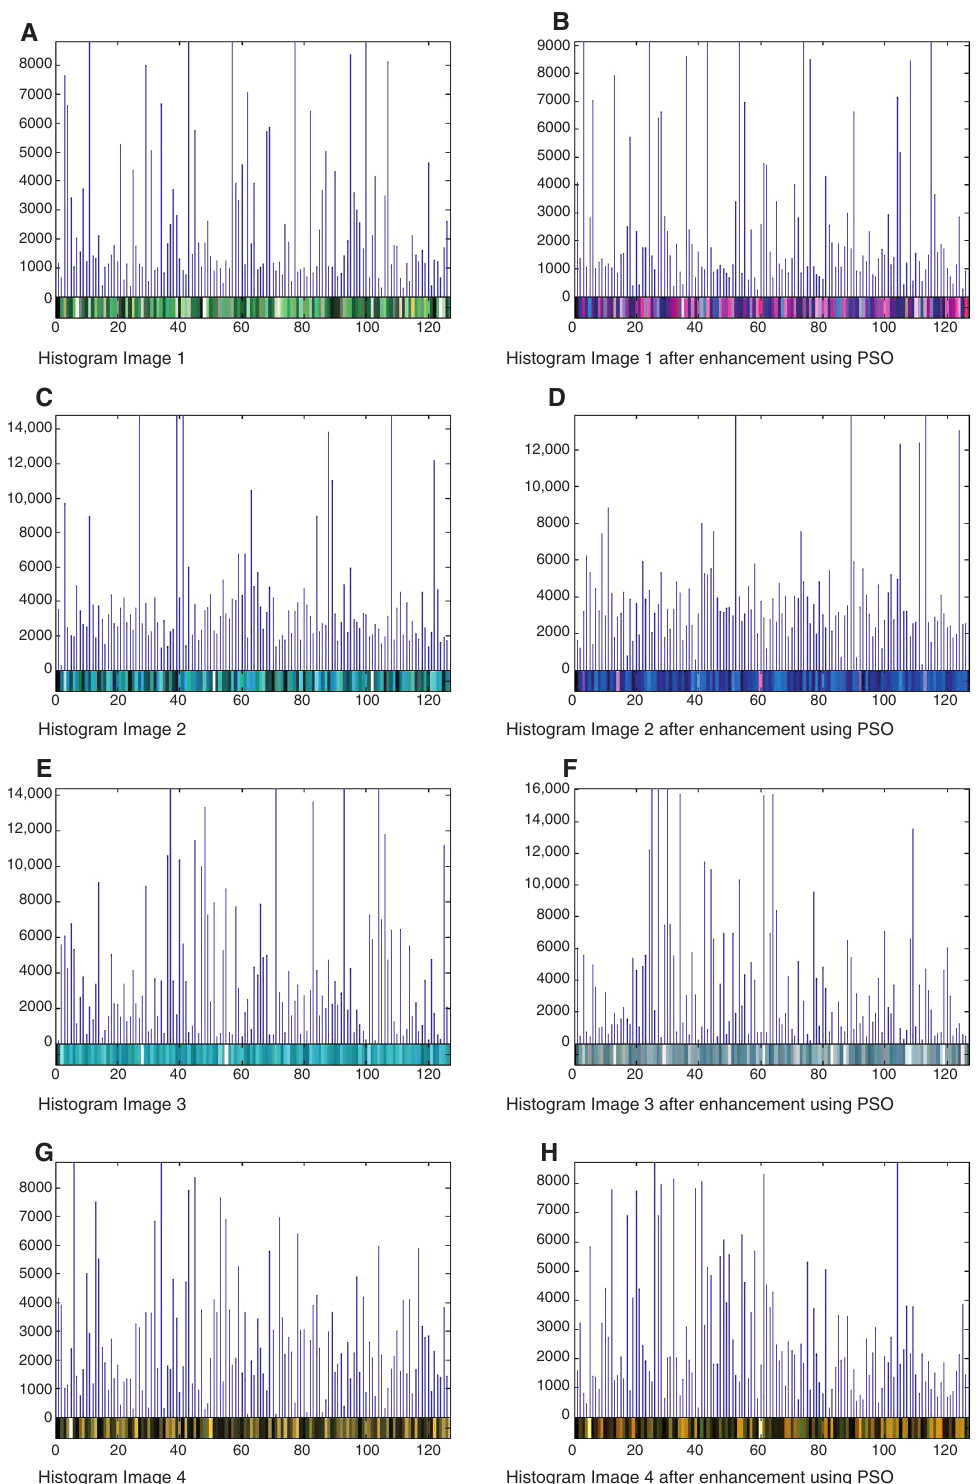
Figure 4. The Original and Enhanced Underwater Image Histograms Using